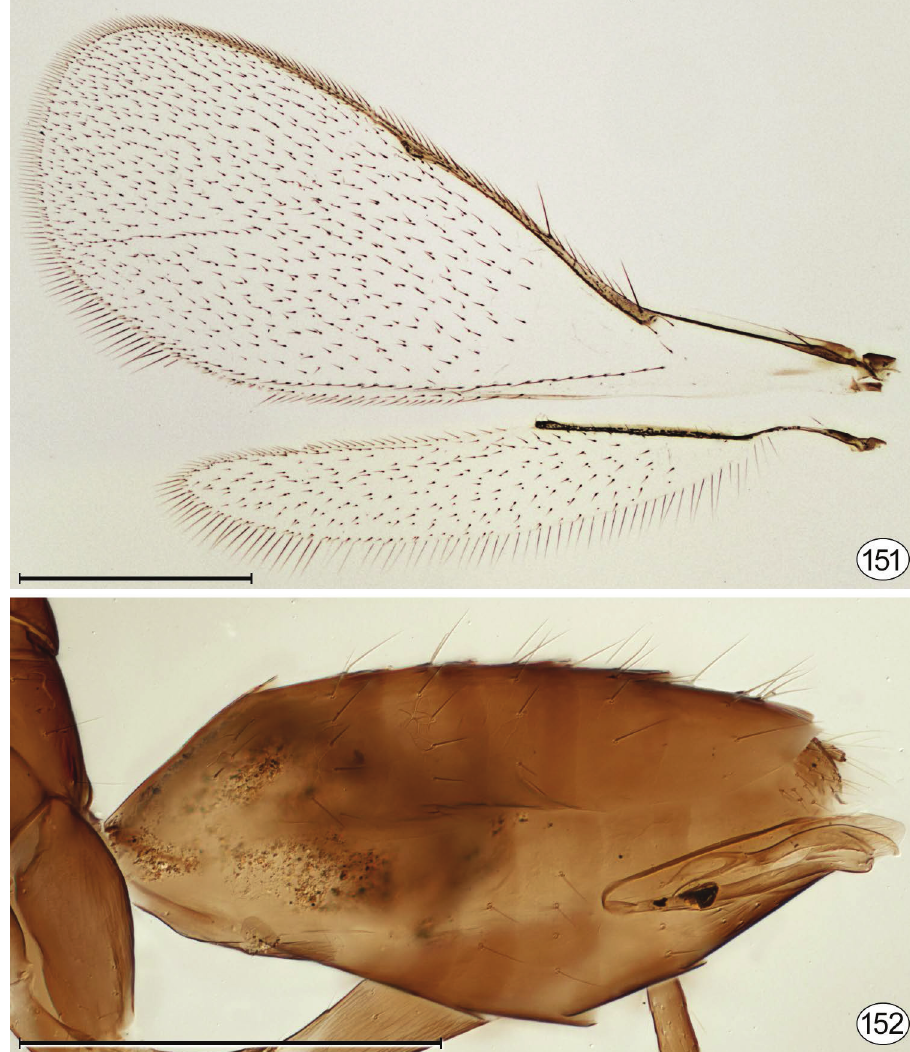
Figures 151–152. Neotriadomerus sp. 4, male (same data as 148–150 ). 151 wings 152 metasoma, lateral. Scale bar = 300 μm. longest marginal setae 64. Metasoma. Gaster length 517, with setae present on sterna but fewer than on terga (Fig. 152). Genitalia length 220 (Fig. 152). 95?), N. longiovipositor (Fig. 121), and N. powerae (Figs 129, 138) and N. sp. 1; the number and distribution of mps are most similar to N. darlingi or N. powerae and the propodeum has 3 setae as in N. powerae . The condensed description given above may help associate the male with a conspecific female when they are collected, preferably together with more